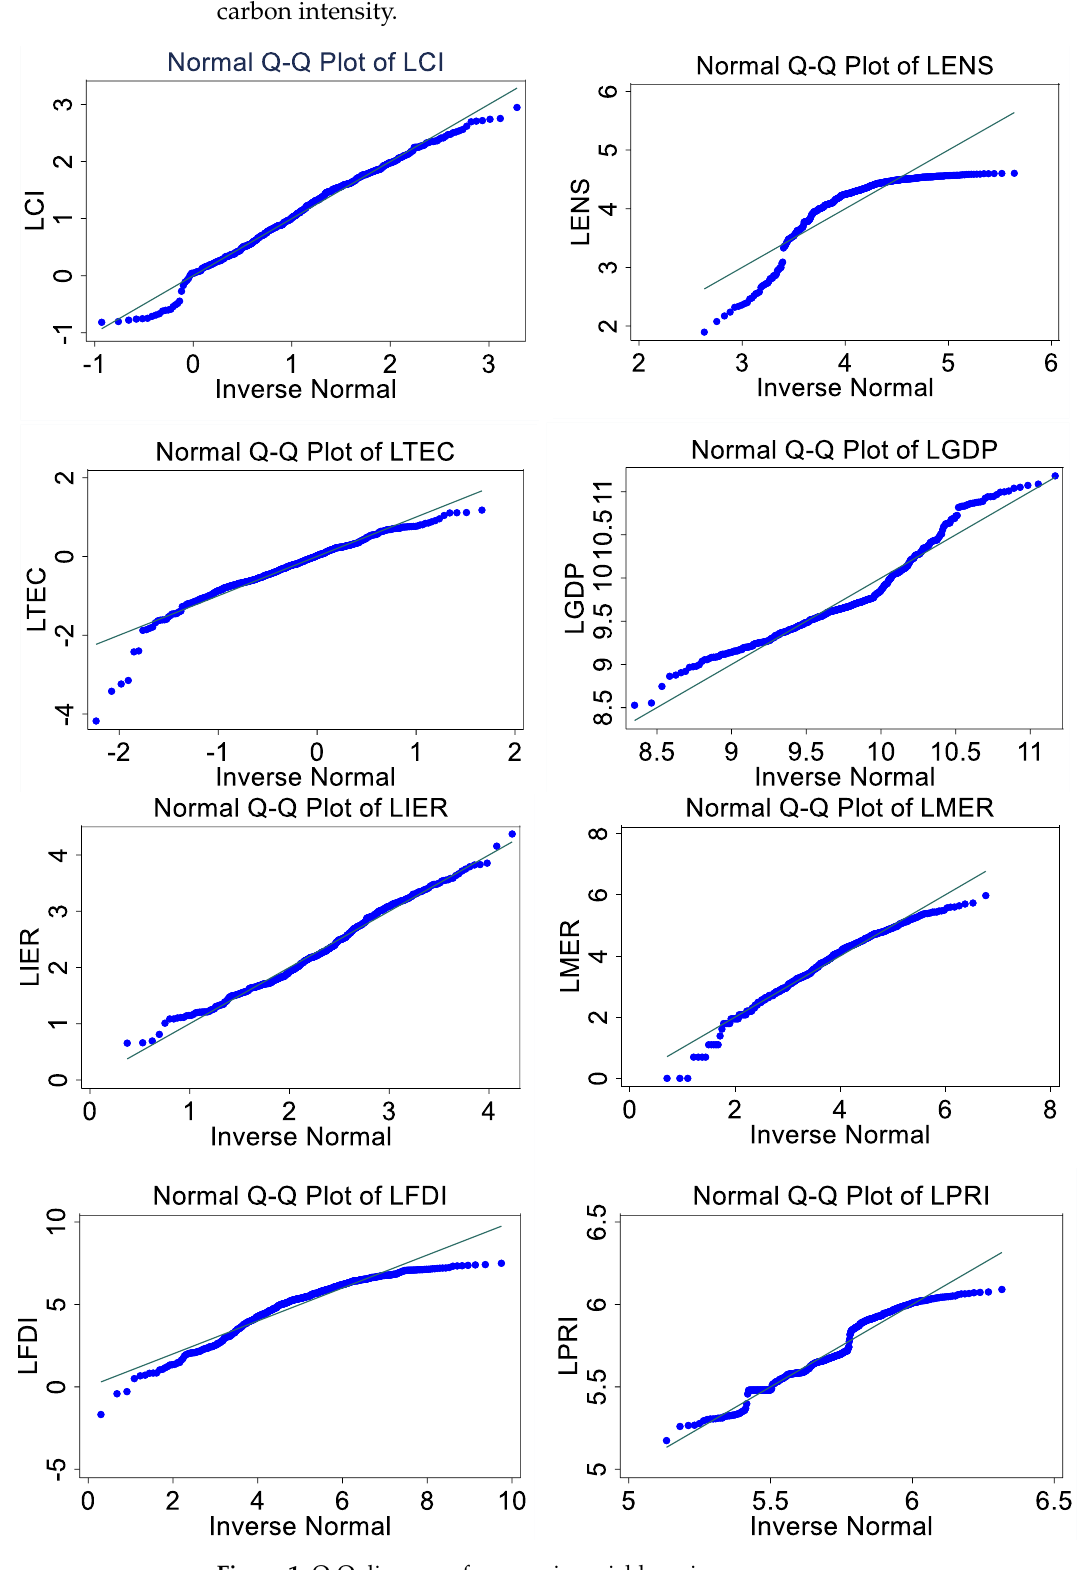
Figure 1. Q-Q diagram of economic variable series.